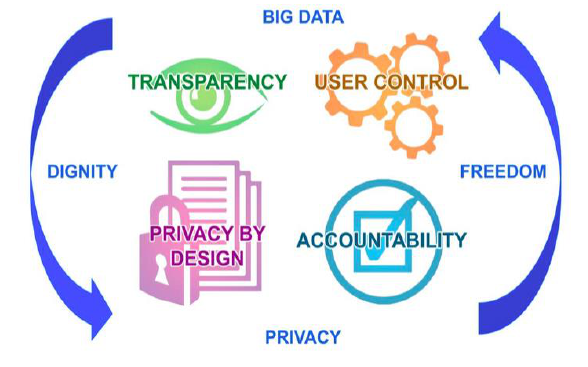
Fig. 3. The link between Big Data and privacy Source: European Data Protection Supervisor (2015, p.